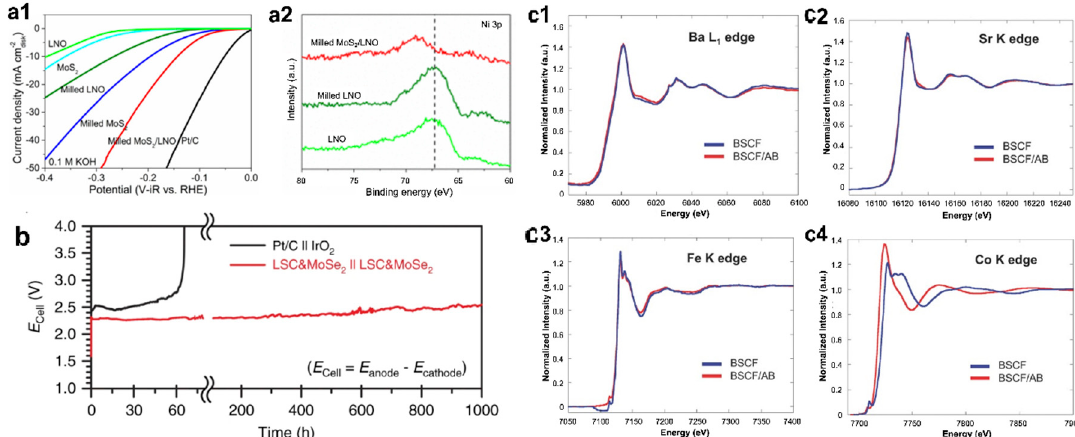
Figure 4. ( a ) Hybridization of perovskite oxide with MoS 2 boosts the HER activity in an alkaline electrolyte: ( a1 ) HER polarization curves obtained in 0.1 M KOH and ( a2 ) the Ni 3p XPS spectra obtained for LNO, milled LNO, and milled MoS 2 / LNO; reproduced with permission [73] Copyright (2018), American Chemical Society. ( b ) Chronopotentiometric test measured at 100 mA cm − 2 for the overall water splitting reaction over 1000 h; reproduced with permission [74] Copyright (2019), Springer Nature. ( c ) Conductive carbon modifies the electronic structure of BSCF. Normalized XANES (X-ray absorption near edge structure) spectra observed at the ( c1 ) Ba L-edge, ( c2 ) Sr K-edge, ( c3 ) Fe K-edge, and ( c4 ) Co K-edge; reproduced with permission [75] Copyright (2015), John Wiley and Sons.